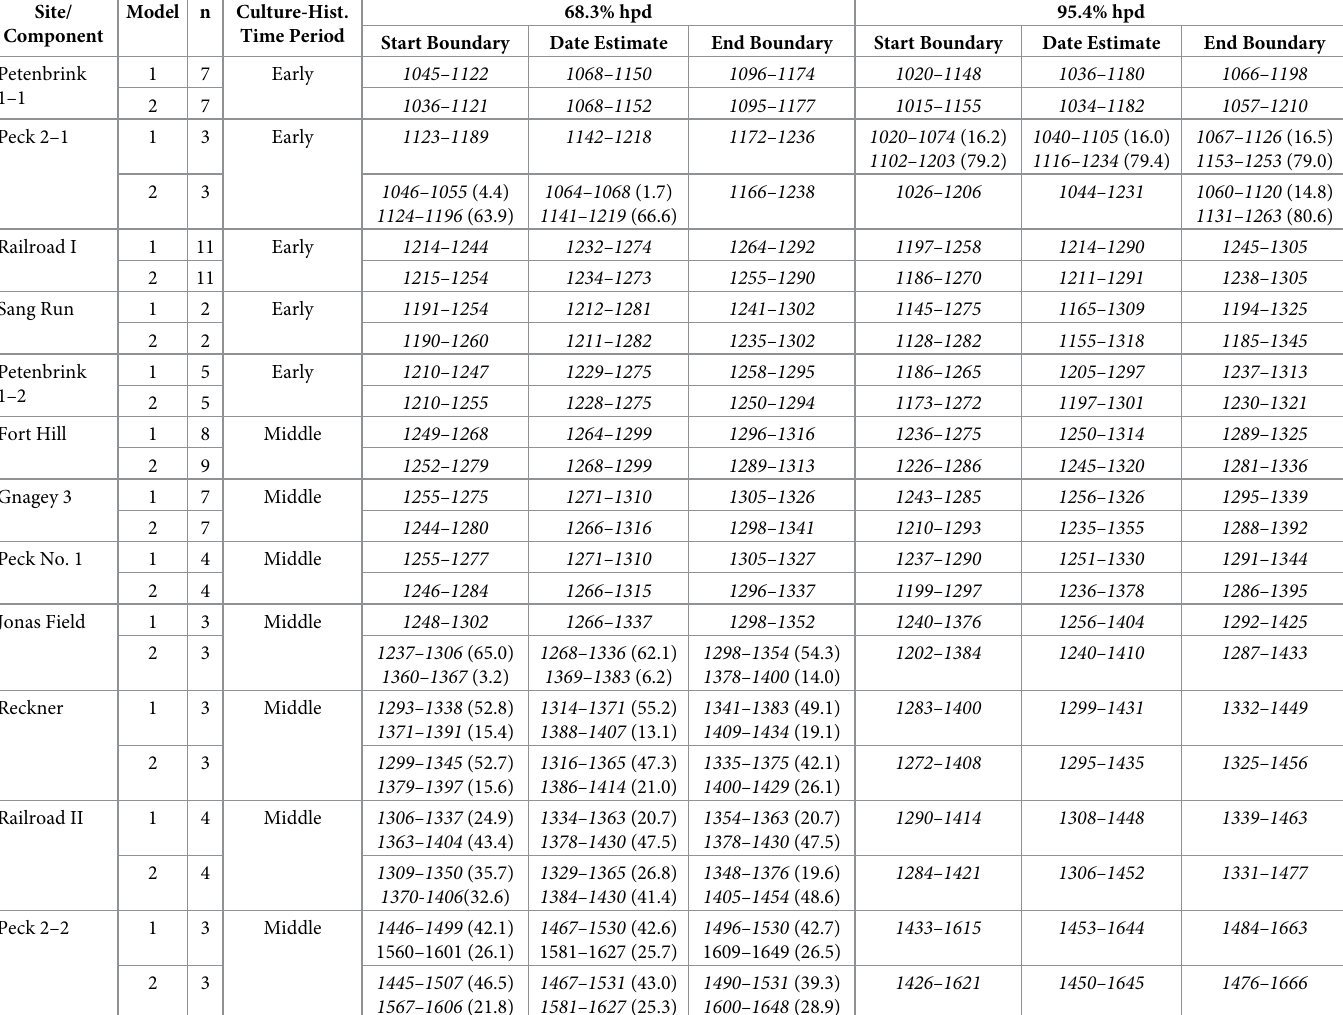
Table 4. Start boundaries, Date estimates, and End boundaries for sites/site components in the Allegheny